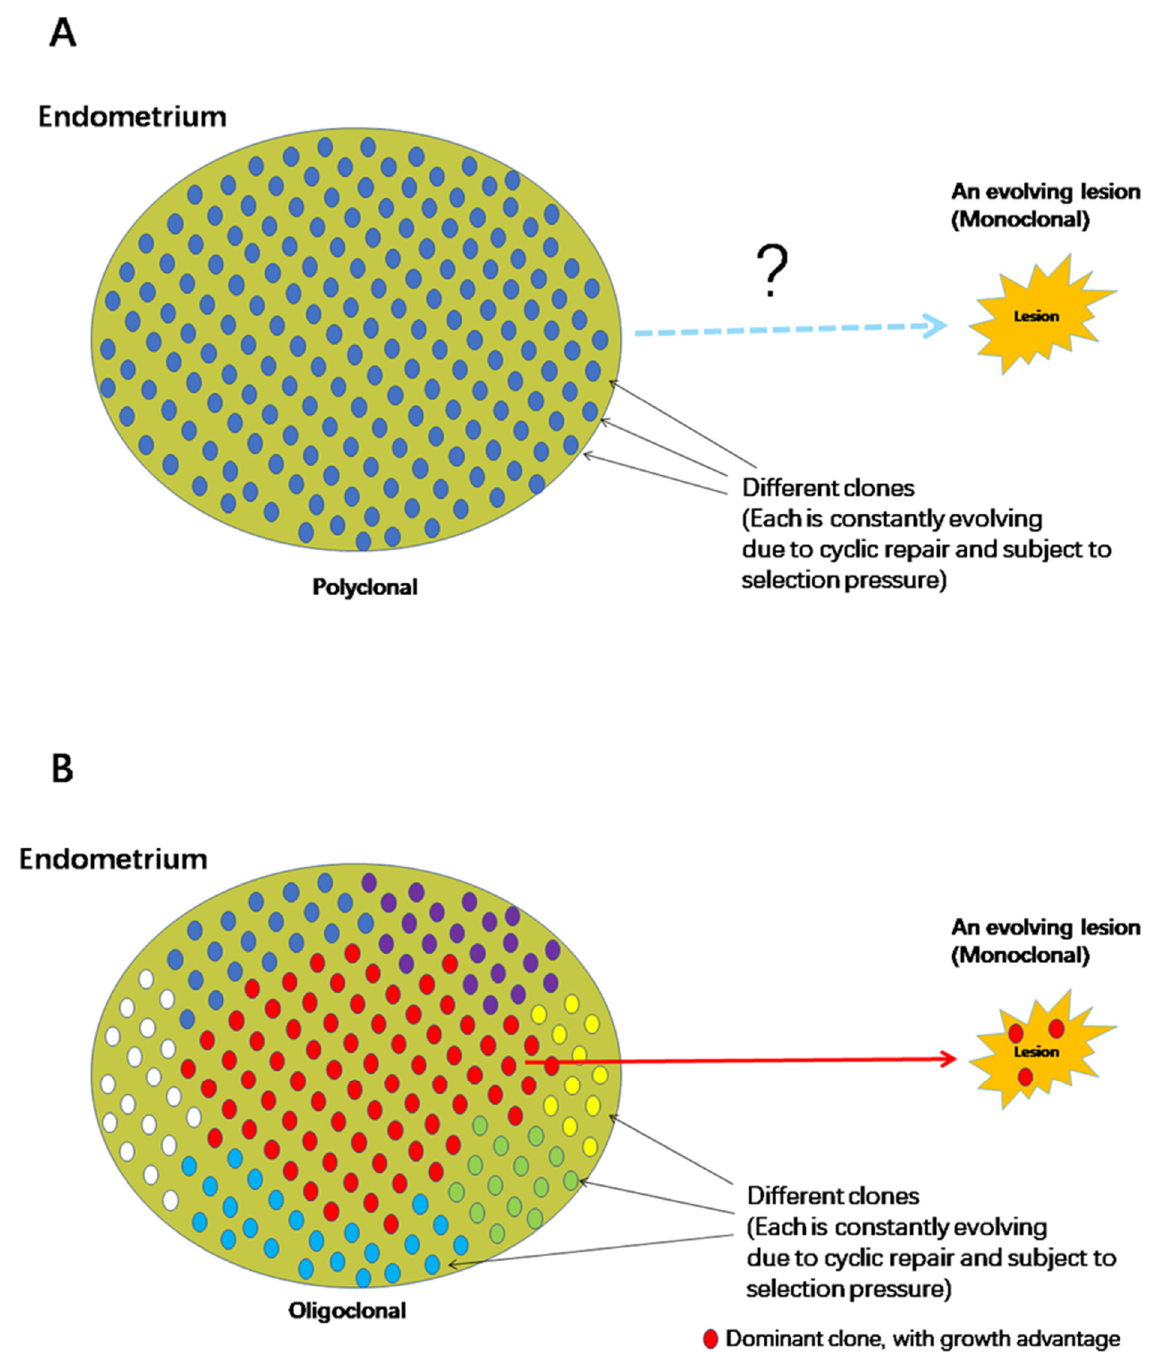
Figure 2. Two scenarios showing the complex phylogenetic relationship between the polyclonal endometrium and monoclonal endometriotic lesion. ( A ) Both eutopic and ectopic endometria are each evolving at their own pace and tempo and in their separate microenvironments, which makes any inference related to the phylogenetic relationship between the two entities challenging. ( B ) Because of cancer-associated mutations that confer selective growth advantages, the endometrium may become oligoclonal. Some clones may dominate and occupy larger areas of the endometrium. Since the chance of test sample coming from the dominant clone is thus increased substantially, this would help establish the phylogenetic relationship between eutopic and ectopic endometrium should the retrograde menstruation theory be true. However, it poses a challenge in establishing that a clone harbouring a particular mutation confers higher risk of developing endometriosis than those